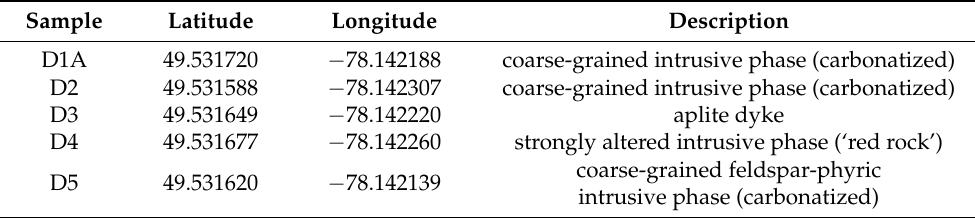
Table 1. Sample location (WGS84 datum) and general